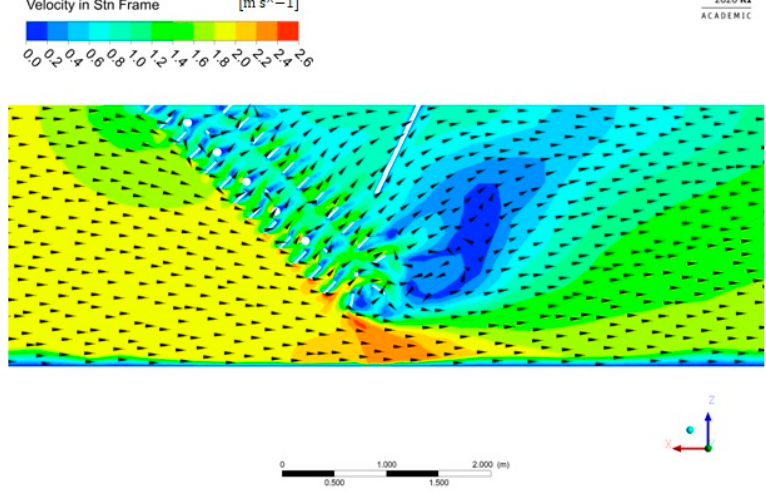
Figure 8. Side view of the velocity profile.